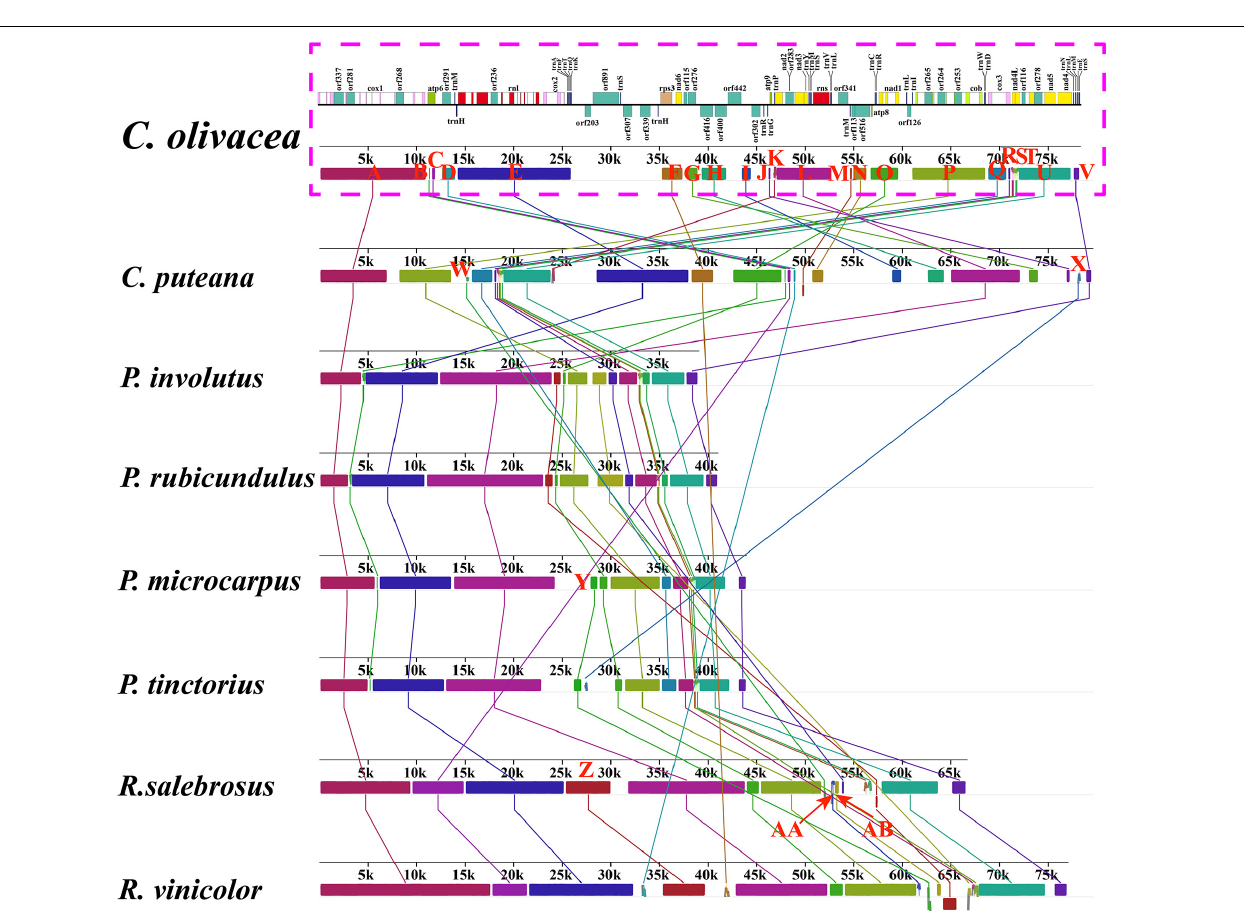
FIGURE 4 | Gene collinearity analysis of eight Boletales species using Mauve v2.4.0. Color blocks of the same color represent homologous regions between different mitogenomes, which are represented by different capital letters. The schematic diagram of Coniophora olivacea’s mitogenome is shown at the top of the